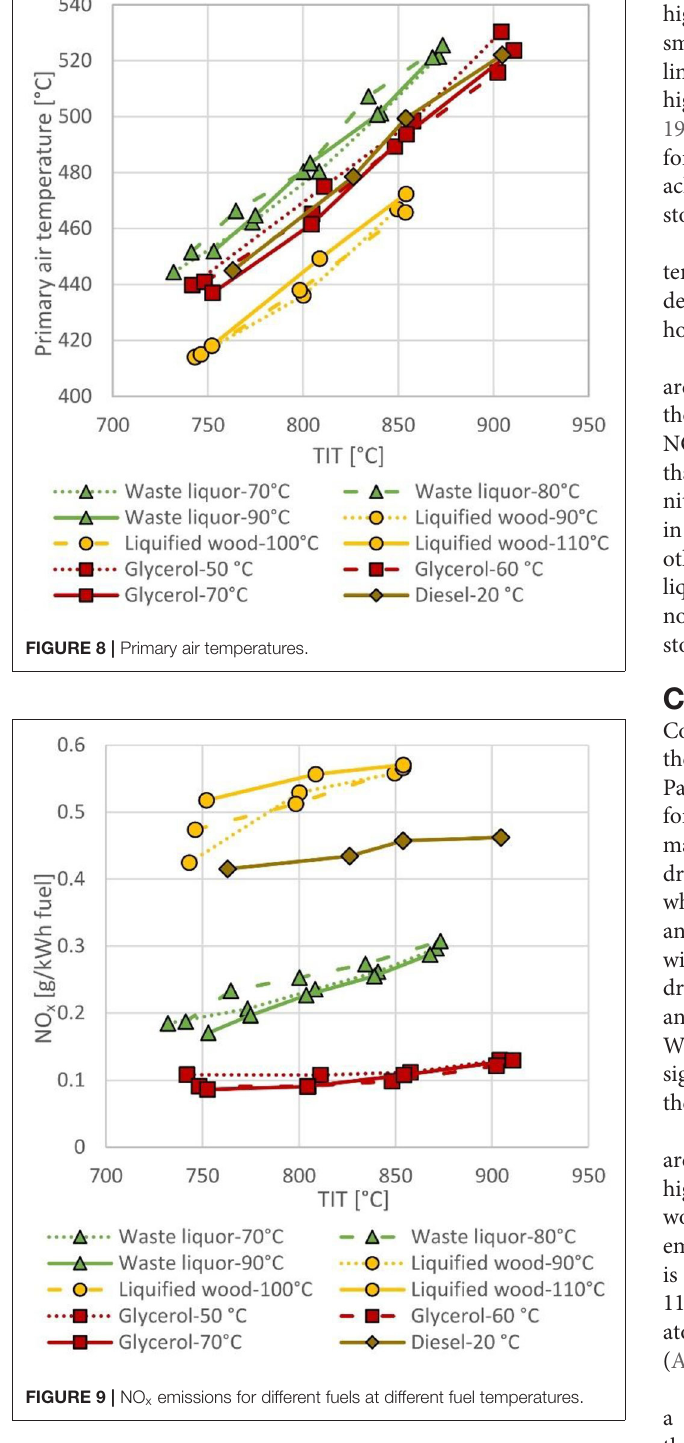
wood exhibits higher NO x emissions which can be linked to high nitrogen content in the